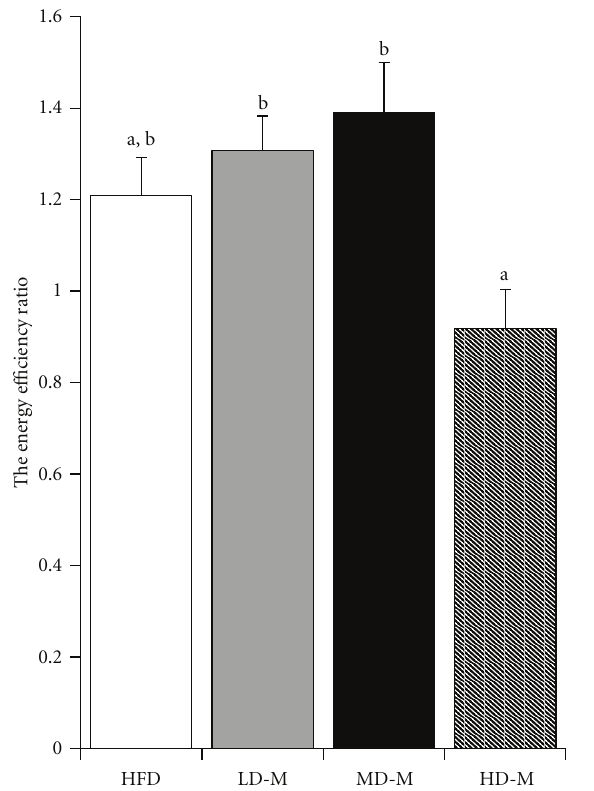
Figure 3: Energy e ffi ciency ratio (EER) was measured after 6-week dietary treatments in rats. Bars represent means ± standard errors, n = 10. For each variable, labelled means without a common letter di ff er, P < 0 . 05. Figure 4: Plasma TAG level was measured after 6-week dietary